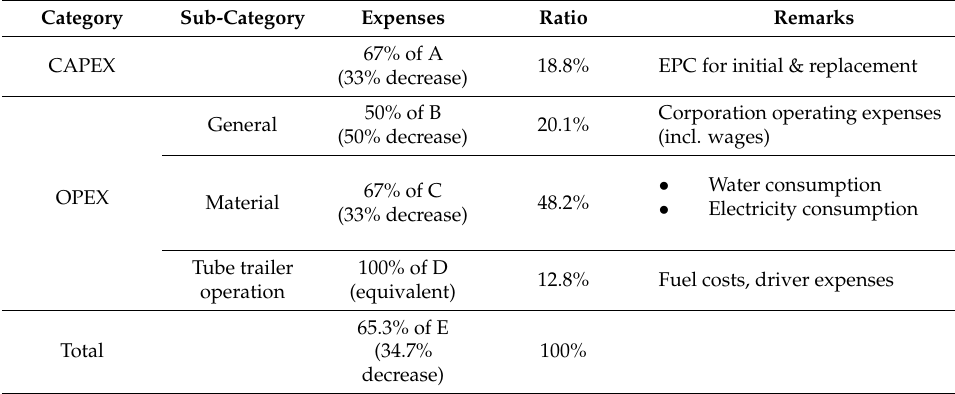
Table 44. Estimation of whole expenses and breakdown (Scenario VII).